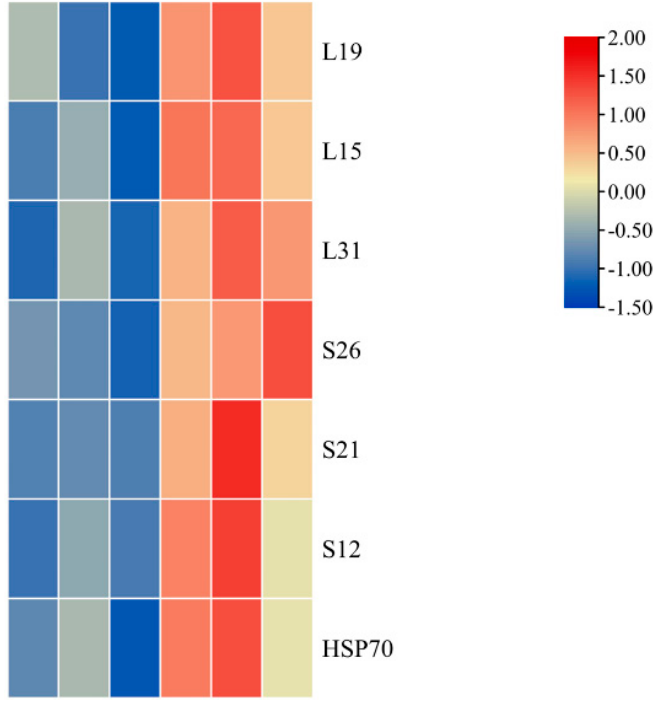
Figure 7. Identified differentially accumulated proteins in ribosome pathways are shown using a heatmap. Green leaves-1, G-1; Green leaves-2, G-2; Green leaves-3, G-3; Mutant leaves-1, M-1; Mutant leaves-2, M-2; and Mutant leaves-3, M-3 (left to right: G-1, G-2, G-3, M-1, M-2, and M-3).